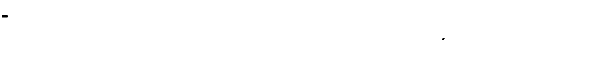
Table 1: PROPORTION OF BABESIOSIS CAUSED BY BABESIA BOVIS BY YEAR, 1973-1978